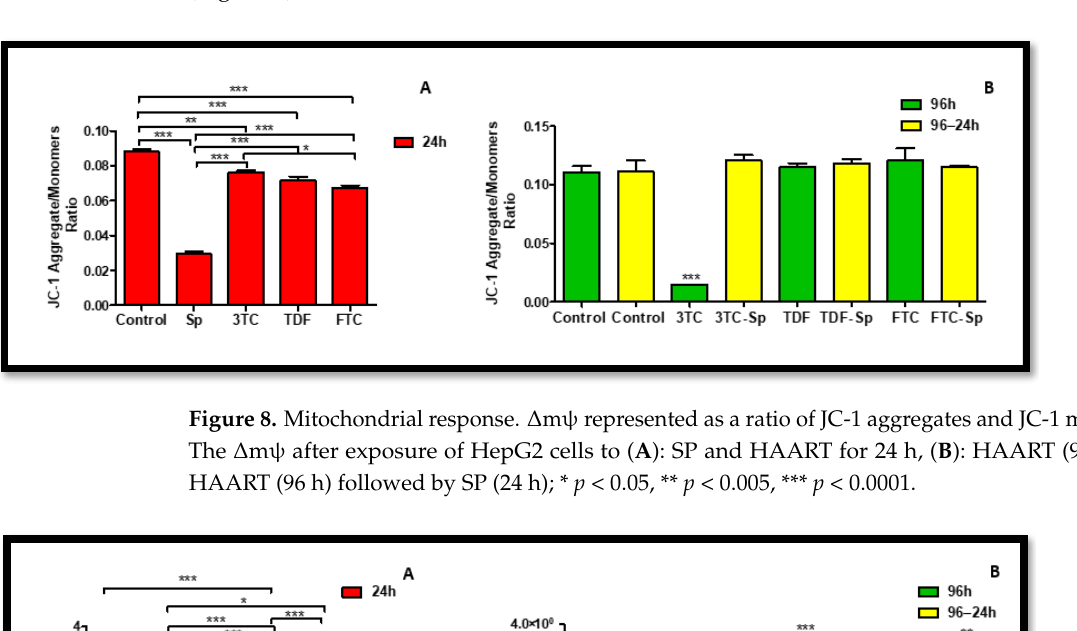
6 of 15 Figure 7. Intracellular ROS levels represented as relative light units (RLU) produced after H 2 DCF- DA staining in HepG2 cells. Intracellular ROS levels after exposure of HepG2 cells to ( A ) SP and HAART for 24 h, ( B ) HAART (96 h), and HAART (96 h) followed by SP (24 h); * p < 0.05, ** p < 0.005, *** p < 0.0001. 2.6. Mitochondrial Stress Responses Mitochondrial membrane potential ( Δmψ ) was measured to determine mitochon- drial health and function. The JC-1 assay was used to determine Δmψ. SP and HAART - treated HepG2 cells showed healthy Δψm A: ( p < 0.0001), B: ( p < 0.0001), and HAART – SP